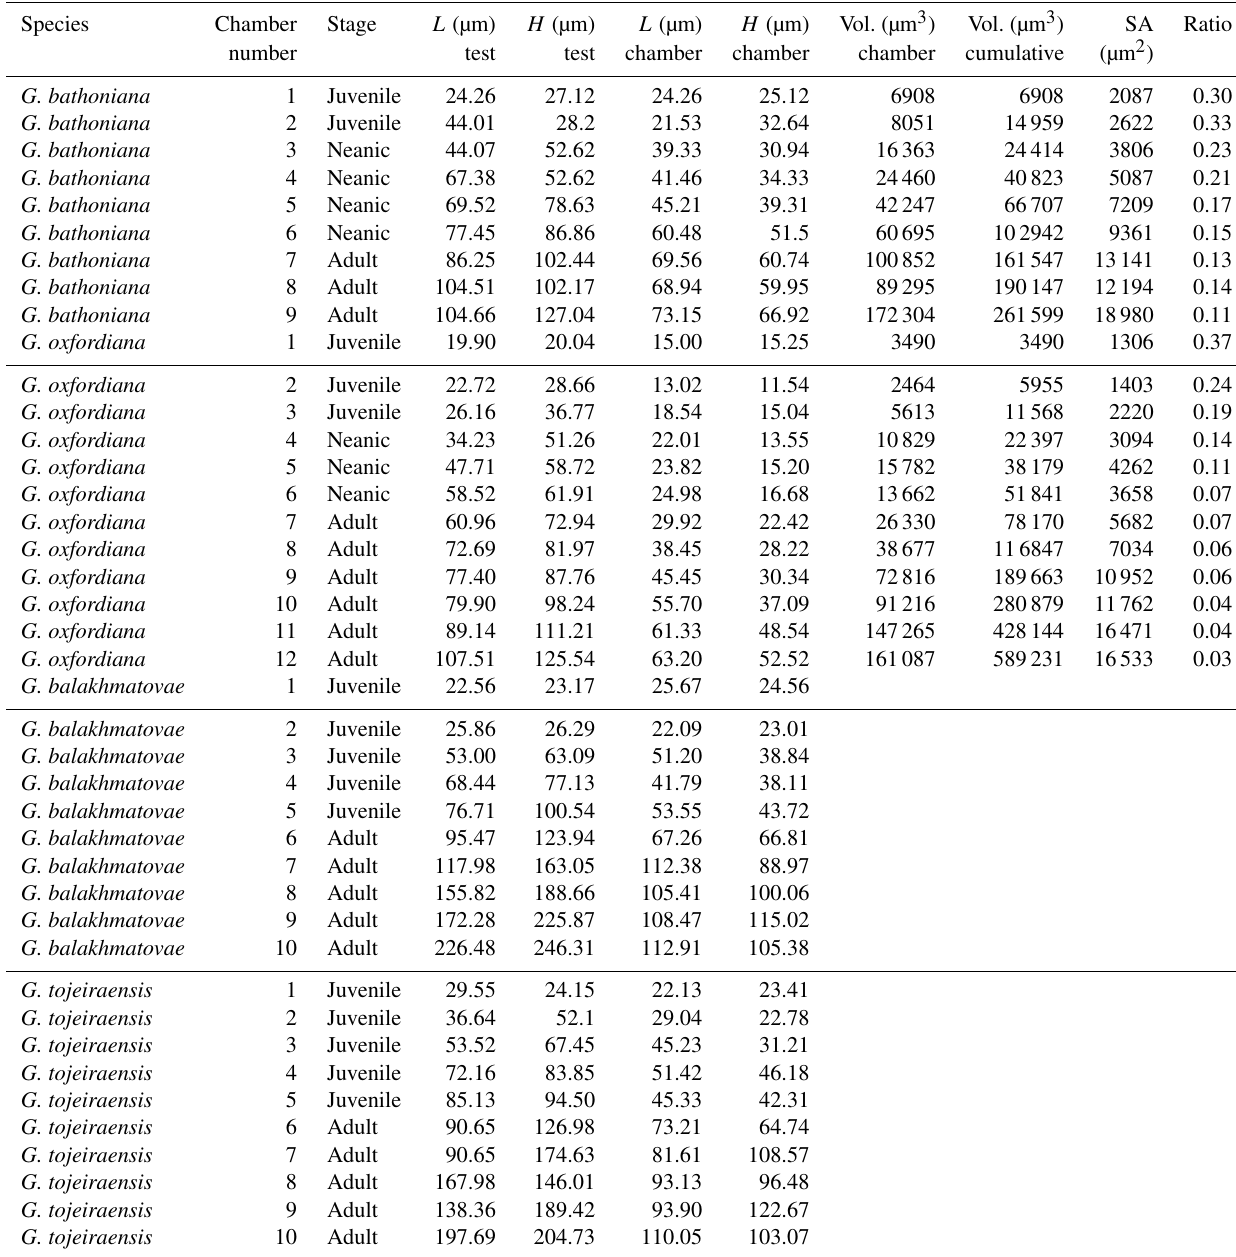
Table 2. Morphometric comparison of each species. G. balakhmatovae and G. tojeiraensis lack data for volume, surface area, and ratio as these were unable to be